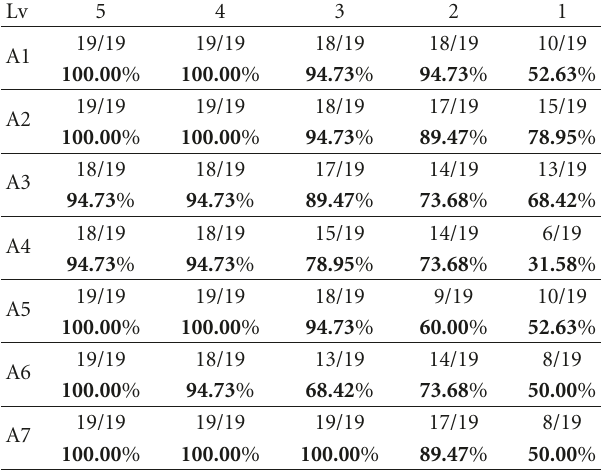
Table 3: Confusion matrix at resolution level 4.